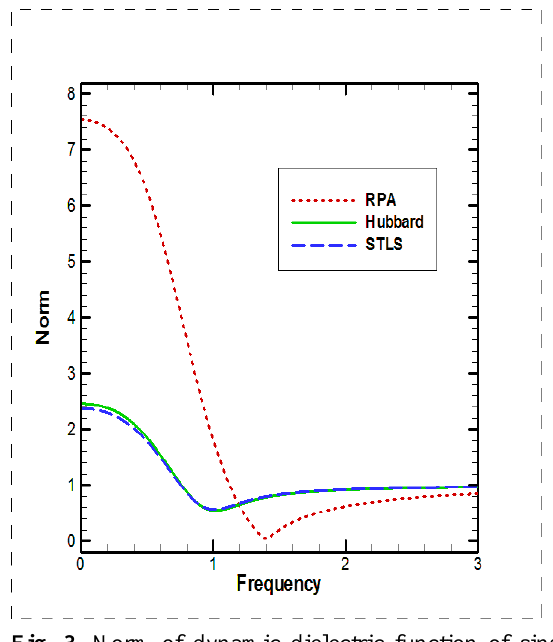
Fig. 3. Norm of dynamic dielectric function of single nanolayer within all approximations.